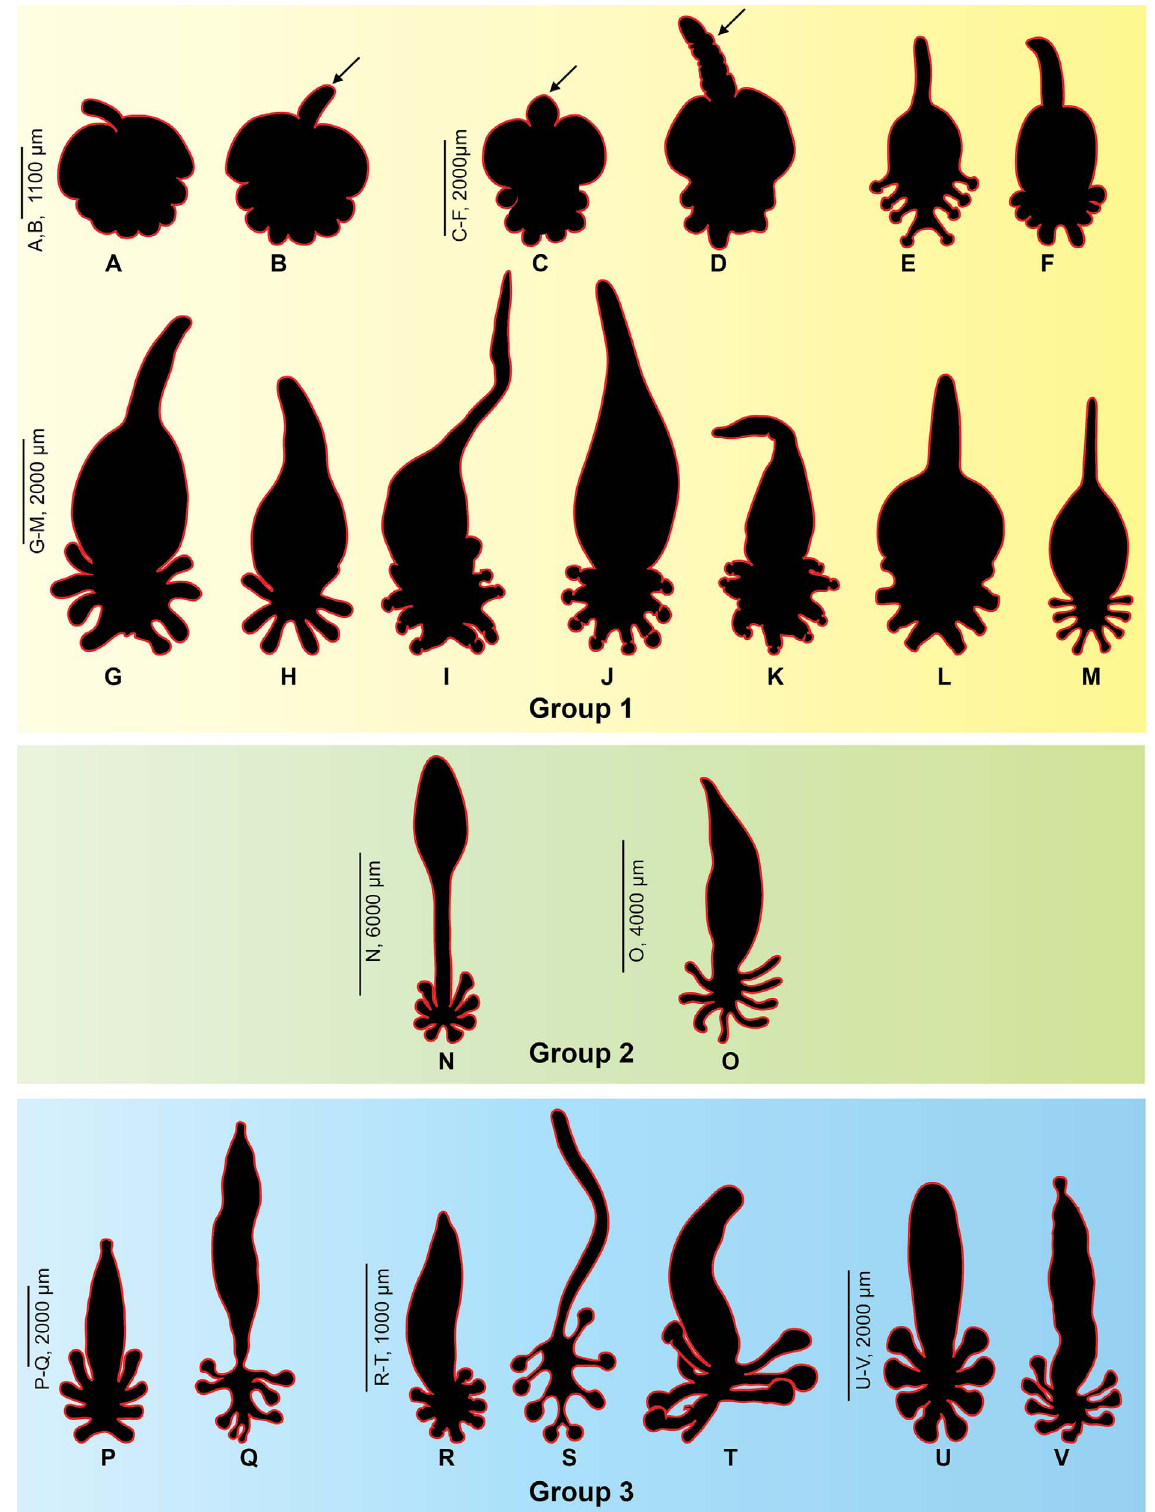
Figure 6. General body shapes of diclidophorid monogeneans from isopods, fi sh buccal cavity and fi sh gills. Group 1, specimens from parasitic isopods. Group 2, specimens from parasitic isopods and/or mouth. Group 3: specimens from gills. A – D, G – K, Cyclocotyla bellones . E, F, Diclidophora merlangi . L, Allodiclidophora squillarum . M, Choricotyle smaris . N, Neoheterobothrium af fi ne . O, Choricotyle elongata . P, Choricotyle chrysophryi . Q, Echinopelma neomaenis . R, Choricotyle hysteroncha . S, Choricotyle multaetesticulae . T, Hargicotyle louisianensis . U, Choricotyle labracis . V, Orbocotyle prionoti . The arrows point to the anterior stem found only in species that are parasitic on